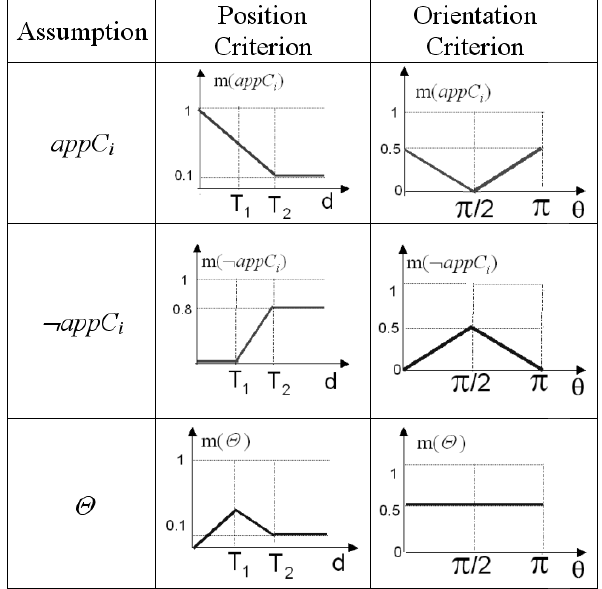
Figure 2: Knowledge modeling for Position and Orientation